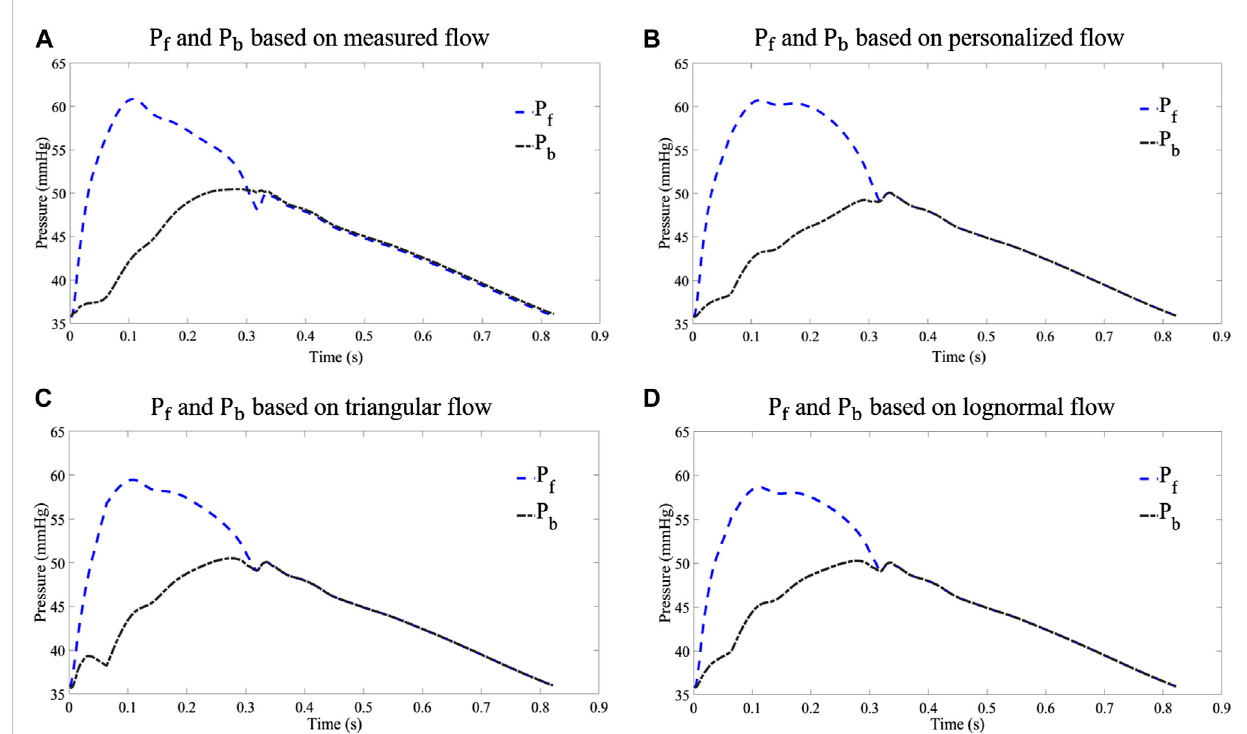
FIGURE 9 Comparison of P f and P b decomposed from different fl ow waves: (A) results of waveform separation based on measured fl ow wave; (B) results of waveform separation based on personalized fl ow wave; (C) results of waveform separation based on triangular fl ow wave; and (D) results of waveform separation based on lognormal fl ow wave approximation.